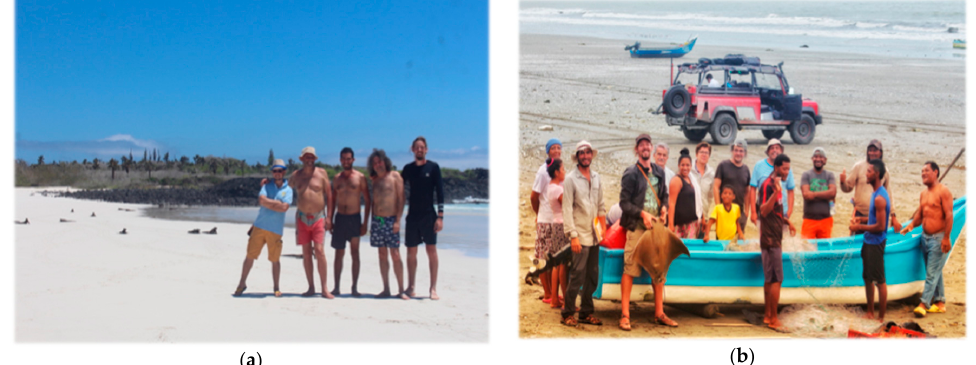
Figure 5. Education for sustainability, research group socializing the study with local population: ( a ) Researchers in Galapagos Island; ( b ) Researchers in Esmeraldas Province.